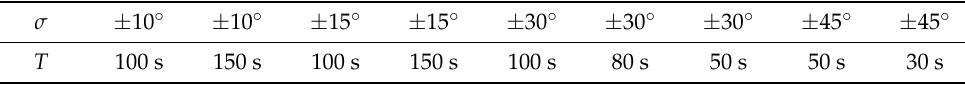
Table A5. Lateral maneuver